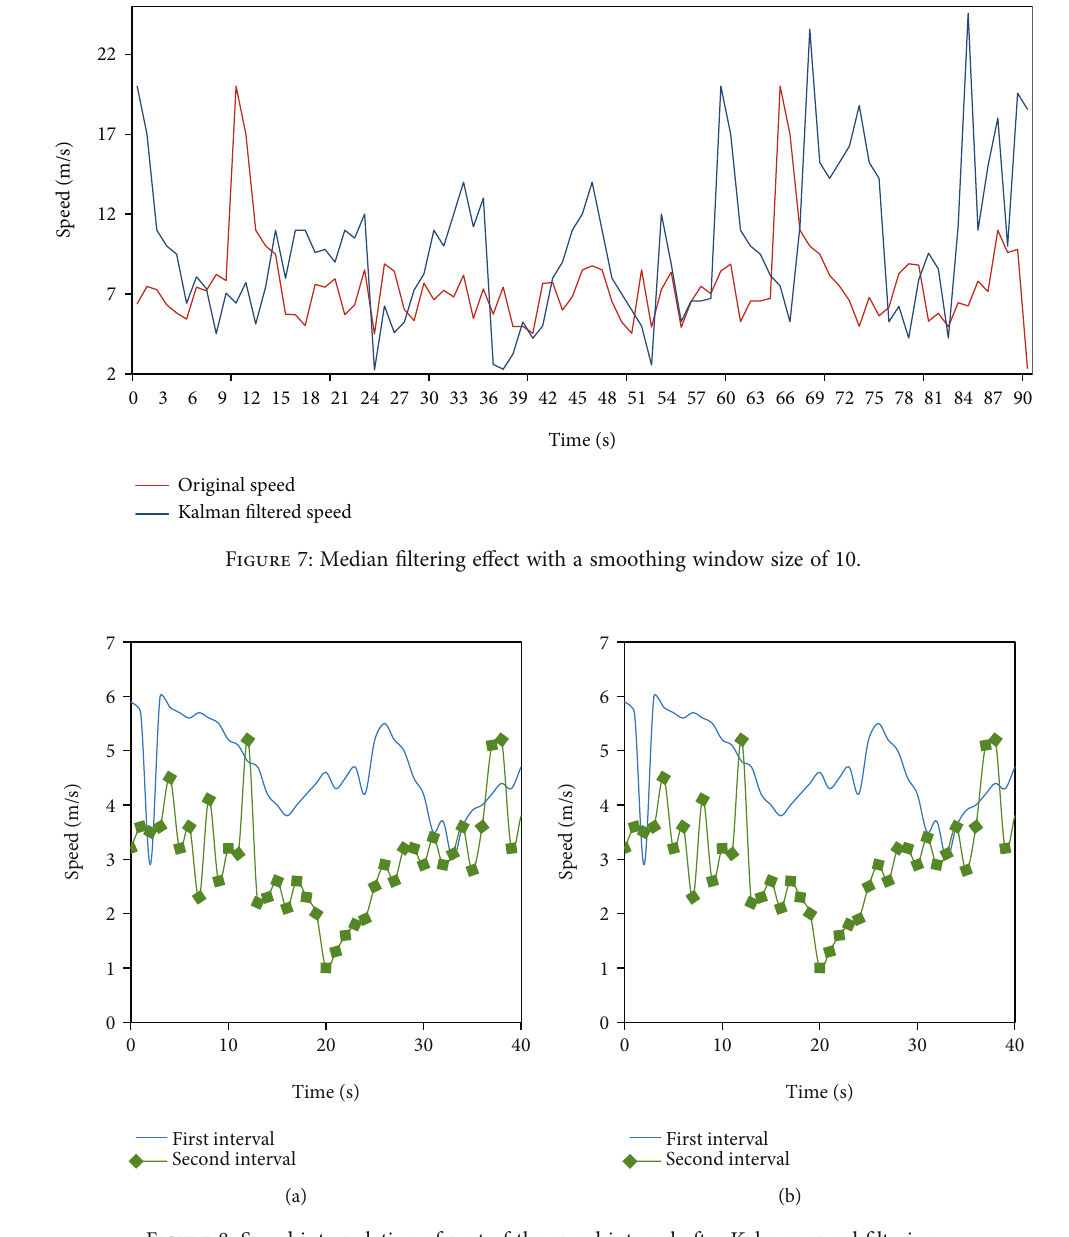
Figure 8: Speed interpolation of part of the speed interval after Kalman speed fi ltering. Table 2: Rotational angular velocity of the three parameters of the dome camera (unit: ° /s).